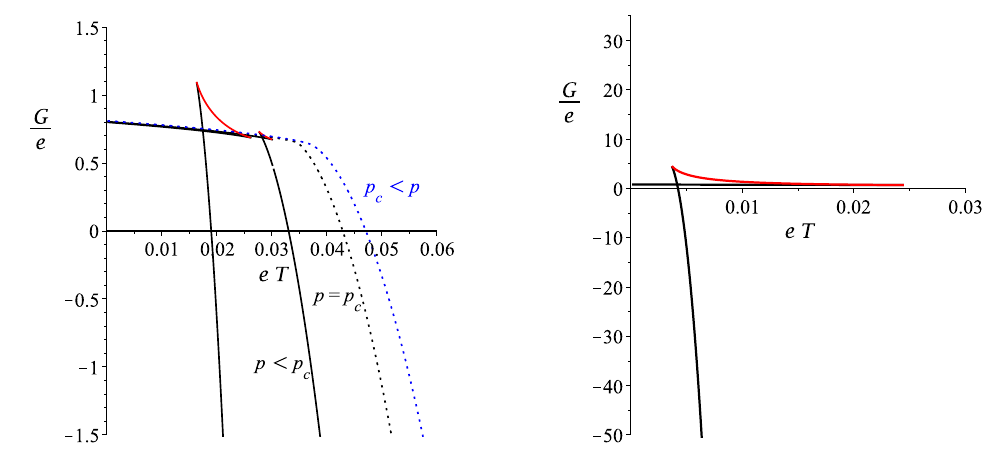
of the electric charge.